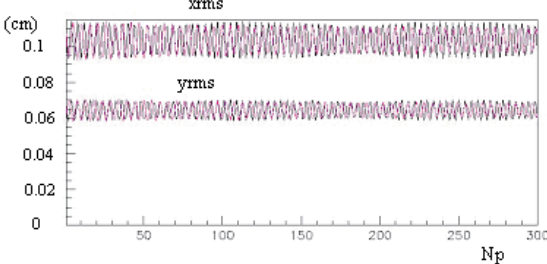
FIG. 4. (Color) Beam betatron frequency distribution with initial Gaussian distribution for s (cid:5) s 0 (cid:2) 0.55 (cid:1) I (cid:2) 95 mA (cid:2) . The odd mode half frequency, v o , is 38 MHz and the even mode half frequency, v e , is 45 MHz.